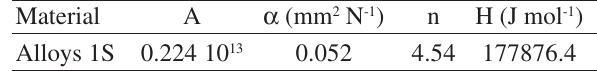
Table 3. Viscosity Law